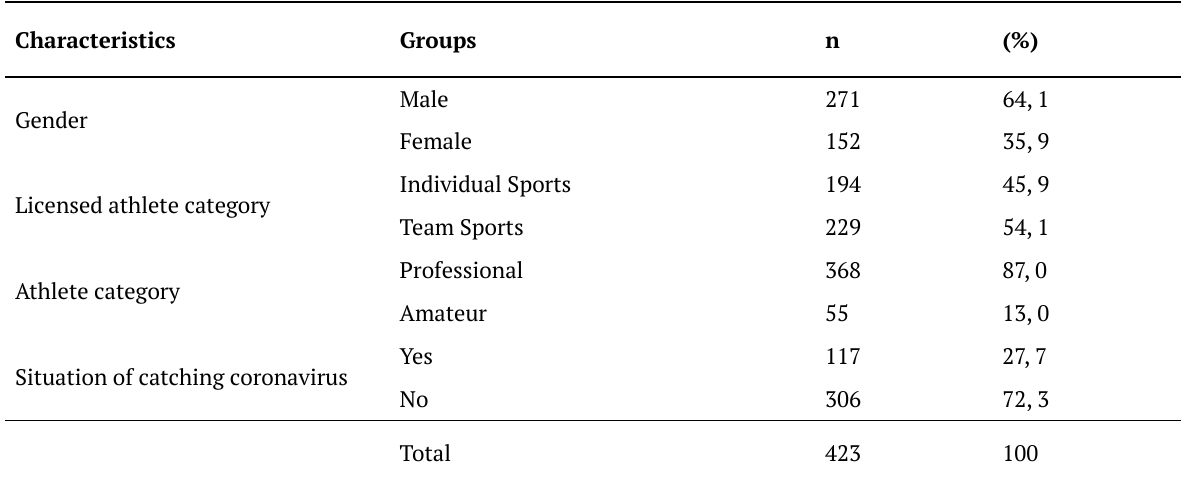
Table 1. Frequency and Percentage Distribution of Students by Demographic Information Characteristics